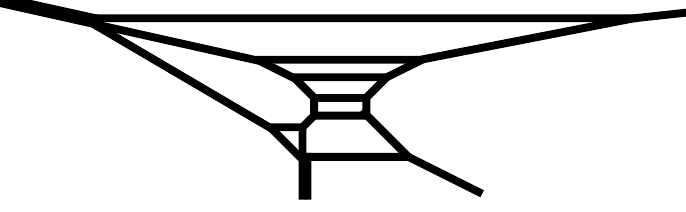
Figure 3 . A 5-brane diagram realizing an SU(6) gauge theory with a half-hypermultiplet in the rank-3 antisymmetric representation. It will turn out that the Chern-Simons level of this theory is (cid:20) = 5 in section 2